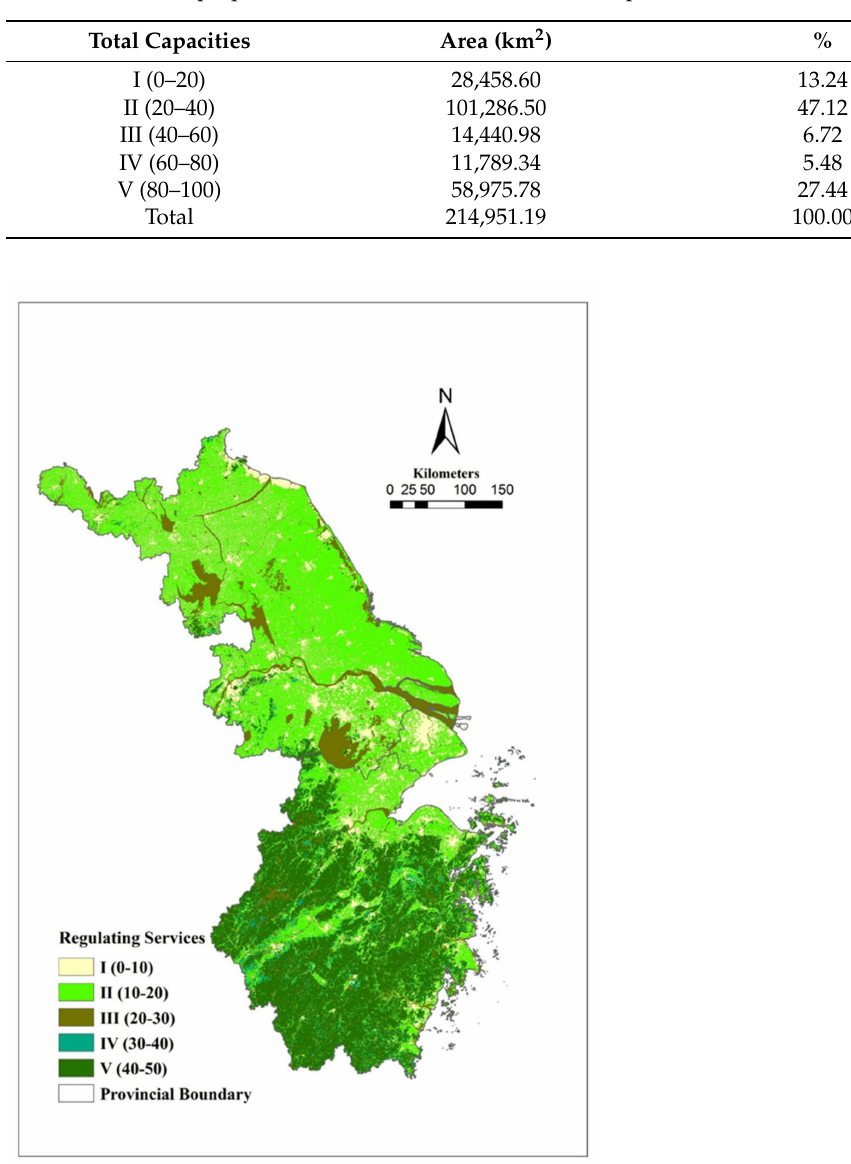
Figure 4. Spatial pattern and levels of regulating services of YRD. Level V and Level II accounted for 27.44% and 47.12% of the total area, respectively (Table 3). Level II occupied the largest area of the region in the five-levels of the region. Level I and Level III had patchy pattern in the region and clustered in the middle of the region. Level I and III accounted for 13.24% and 9.73% of the total area, respectively. Different from the pattern of the total capacities, the area with Level IV in the total capacities degraded to Level III in the regulating services. Level IV dispersed in the south of the region, which covered most areas of the Zhejiang Province and accounted for 2.48% of the total